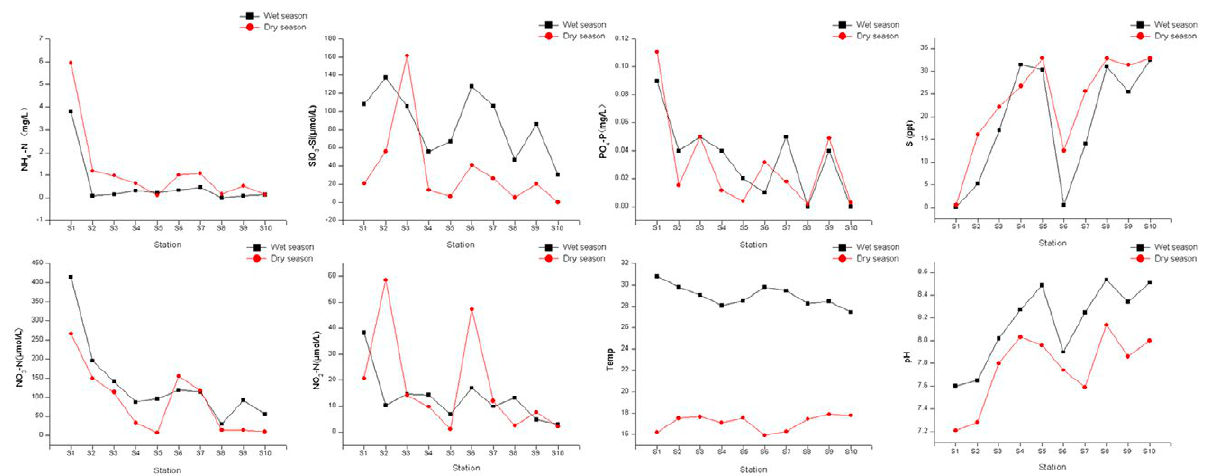
Fig. 2. – Water physicochemical parameters of the Pearl River